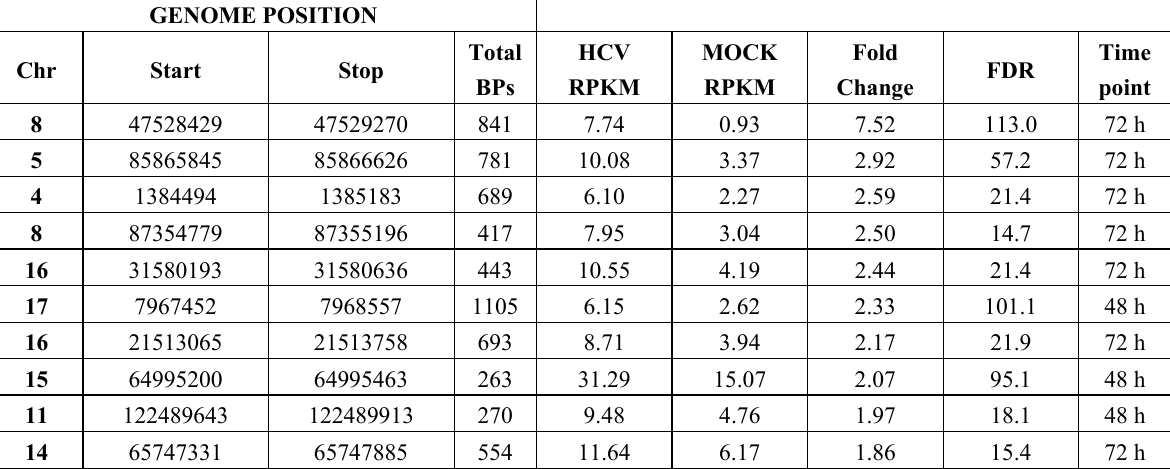
Table 4. Unannotated transcripts increased during acute HCV infection. It displays ten unannotated transcripts with their respective chromosome location, transcript size, fold change and FDR. RPKM = reads per kilobase per million